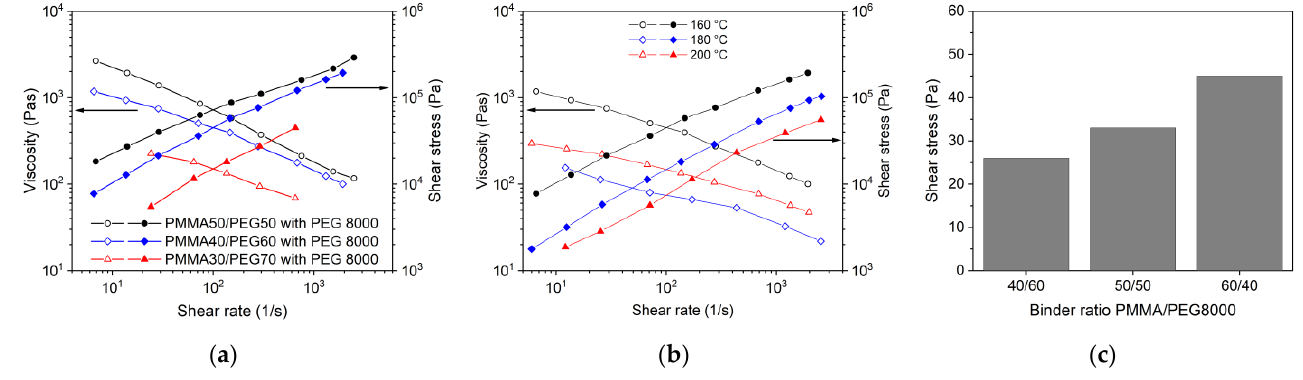
Figure 12. ( a ) Change of melt flow with increasing PEG 8000 moiety in the binder (solid load; 60 vol%, T= 160 °C, SA as surfactant); ( b ) temperature influence on a PEG60/PMMA40 feedstock applying PEG 8000 (solid load 60 vol%, SA as surfactant); ( c ) variation of the PEG 8000/PMMA ratio and resulting shear stress change for the yield point (SA as surfactant).